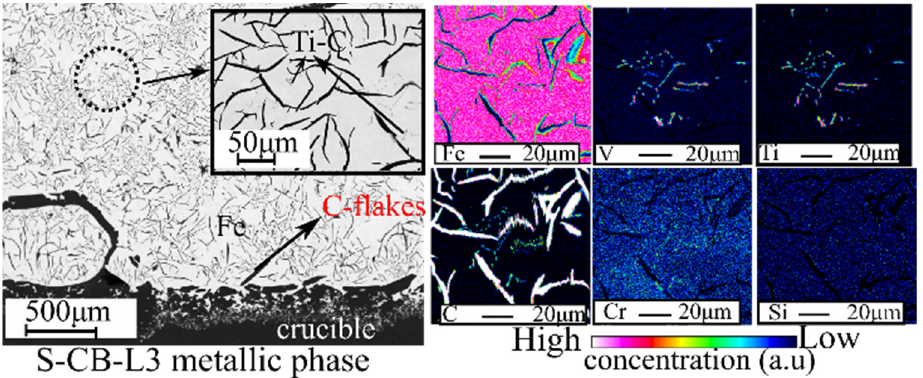
Figure 12. Backscattered image and X-ray elemental mapping of the metallic phase from S-CB-L3.